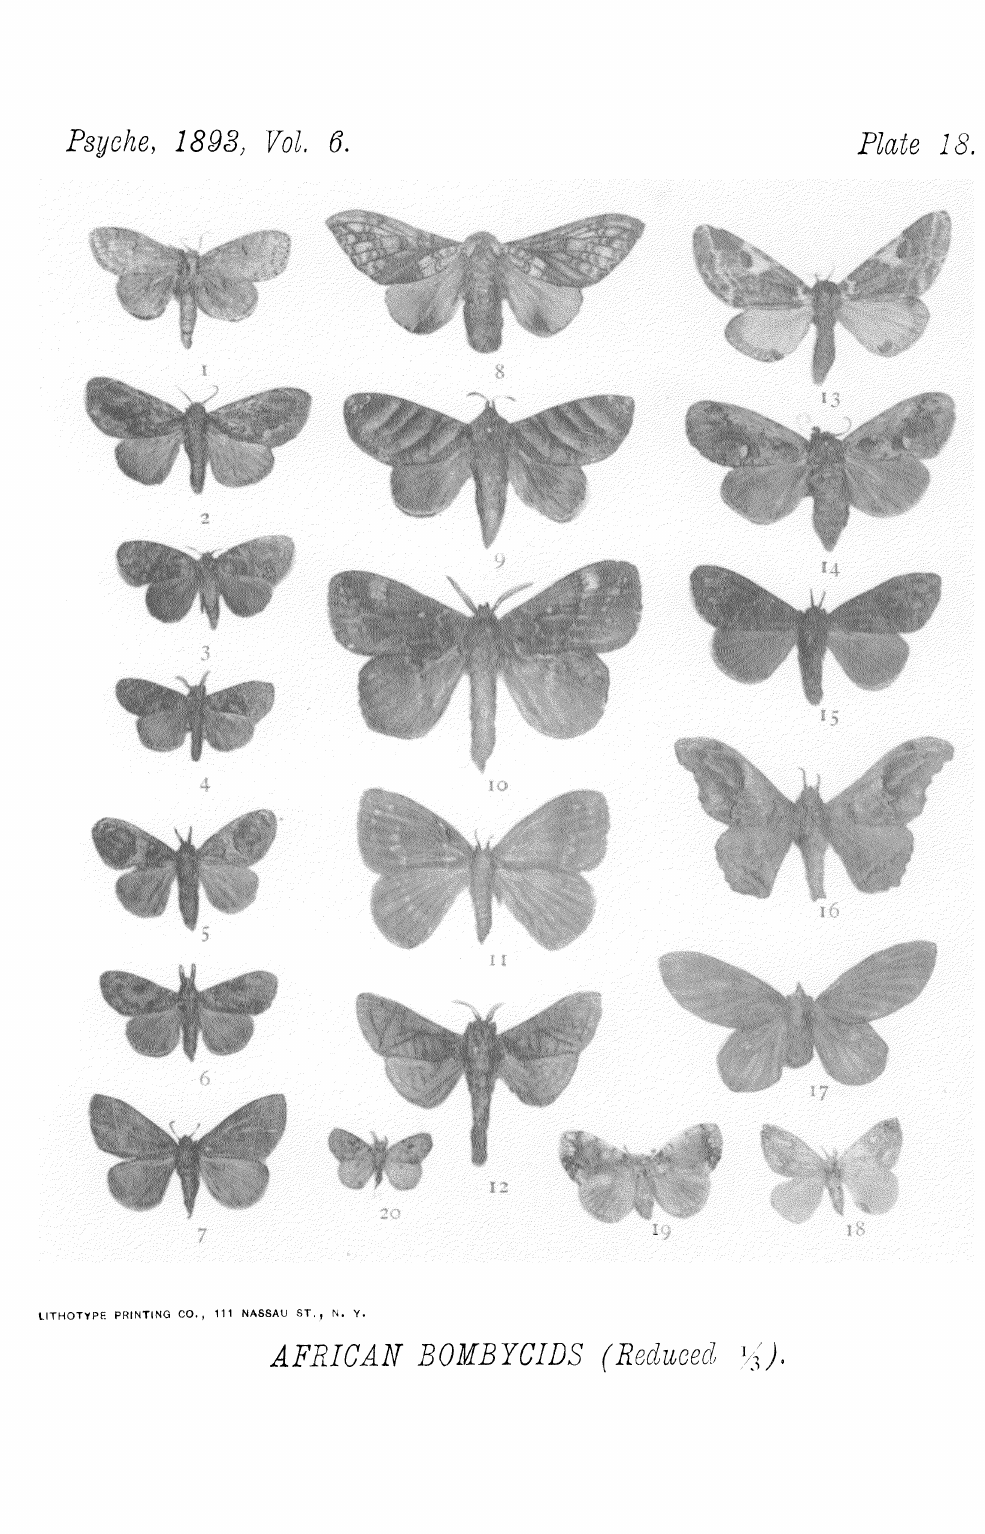
LITHOTYPE PRINTING CO., 111 NASSAU ST. AFRICAN BOMB YCIDS (Rdcec ,: